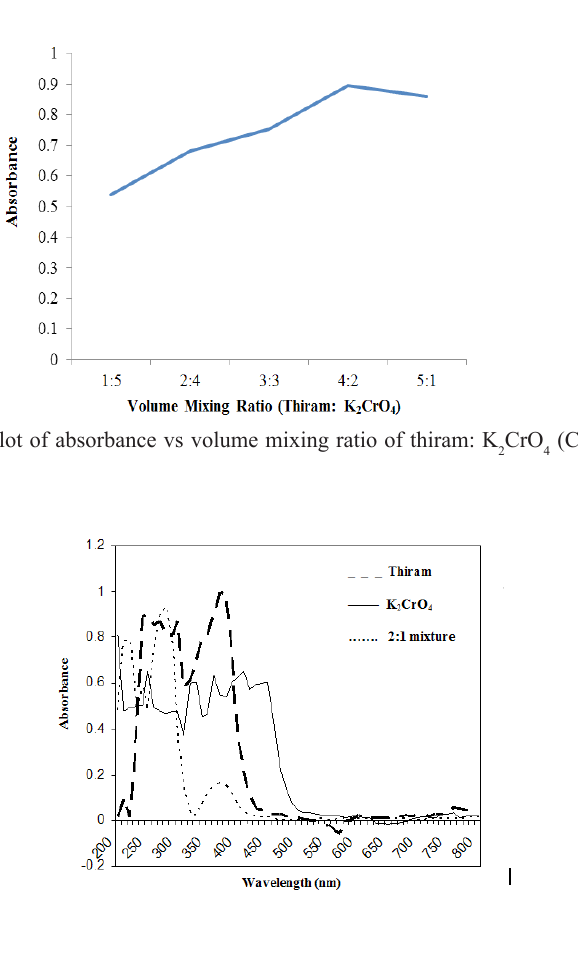
CrO (continuous line) and 2:1 mixture of thiram: 2 4